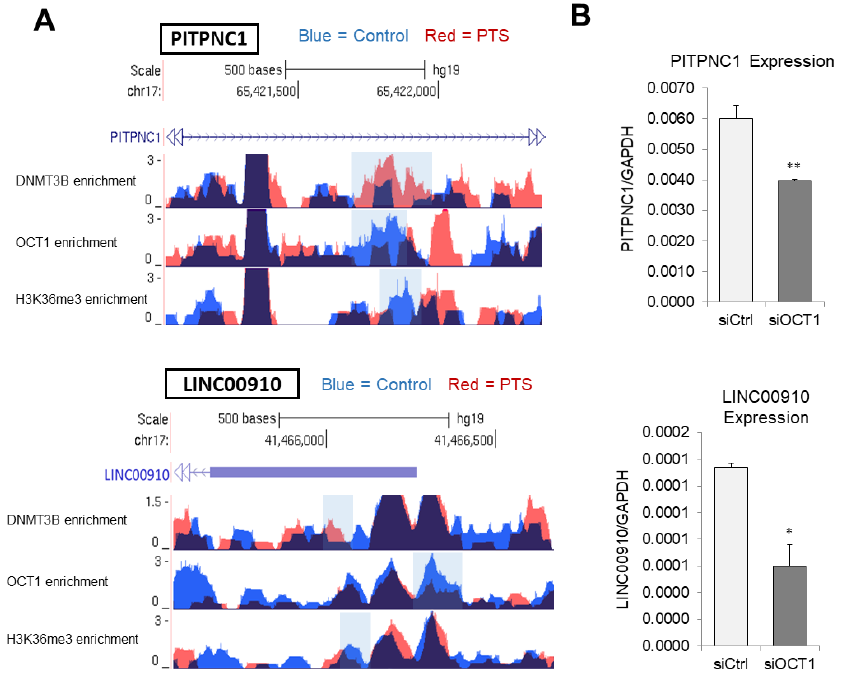
Figure 4. Increased DNMT3B binding and reduced H3K36me3 occupancy is associated with PITPNC1 and LINC00910 downregulation and hypermethylation of the enhancer regions in response to PTS in breast cancer cells. ( A ) Genome browser tracks depicting DNMT3B, OCT1, and H3K36me3 enrichment in occupancy within PITPNC1 and LINC00910 enhancer regions in vehicle-treated (blue, control) and PTS-treated (red) MCF10CA1a breast cancer cells. The data are based on ChIP-seq analyses. The blue-shaded region represents the DNMT3B-increased, OCT1-reduced, and h3K36me3-reduced overlapping peaks. ( B ) Expression of PITPNC1 and LINC00910 , as determined by QPCR in MCF10CA1a breast cancer cells with OCT1 knockdown, which was generated using siRNA. Cells transfected with scrambled siRNA (siCtrl) served as a control. All results represent mean ± SD of three independent experiments; ** p < 0.01, * p < 0.05. To determine the role of OCT1 in the regulation of PITPNC1 and LINC00910 tran- scription, we tested the expression of the genes in MCF10CA1a cells with siRNA-medi- ated OCT1 depletion, which were generated in our previous study [20]. OCT1 depletion led to a profound downregulation of the two tested genes (Figure 4B). It indicates that OCT1 plays a role in driving the expression of PITPNC1 and LINC00910 . 4. Discussion A crucial role of enhancers in gene transcriptional activity has long been an area of interest, with a more recent focus on the contribution of epigenetic components, including DNA methylation, in regulating the activity of enhancer regions [10,14,15]. Dysregulation of DNA methylation patterns and aberrant expression of DNMTs have been observed across multiple cancer types [59,60]. For instance, tumor suppressor genes are often meth- ylated and silenced during carcinogenesis, whereas oncogenes lose methylation within their regulatory regions, including enhancers, and become actively transcribed [5,20]. Our group has shown that stilbenoids mediate transcriptional repression of MAML2 through altering epigenetic patterns at the enhancer region of this oncogene [20]. DNMT3B was suggested to be a key player in MAML2 hypermethylation and silencing in response to stilbenoids.